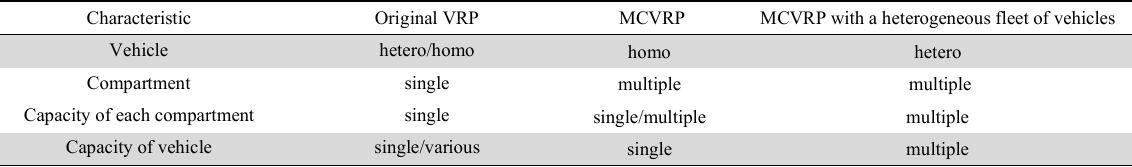
Comparison of the